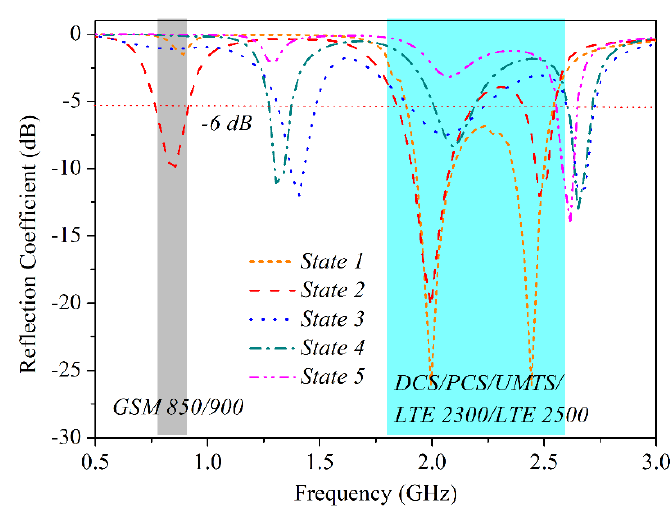
Figure 10. Photograph of the prototype.